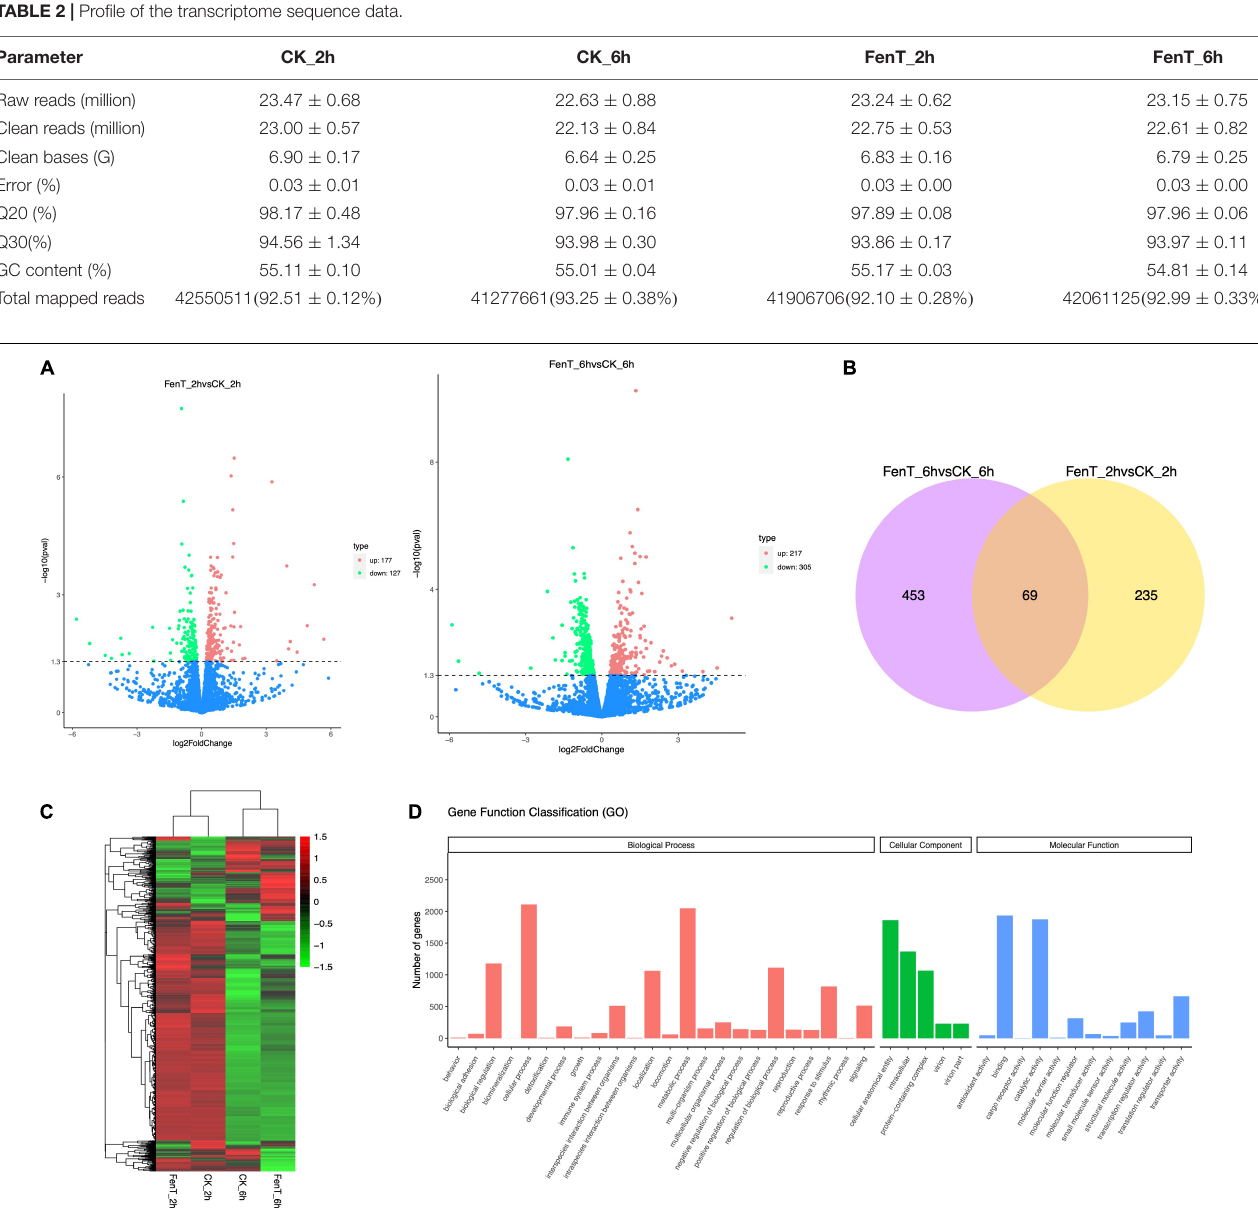
FIGURE 5 | Volcano plots, Venn diagrams, a heatmap and the GO functional classification. (A) The differences in the distribution and density distribution of gene expression in CK_2h, CK_6h, FenT_2h, and FenT_6h. (B) Venn diagrams showing the numbers of common DEGs that are shared in comparisons among CK_2h, CK_6h, FenT_2h, and FenT_6h. (C) Heatmap of the common DEGs in the three treatment groups. (D) GO functional classification results of DEGs shared by the three treatment groups. The DEGs were assigned to three categories: cellular component, molecular function and biological